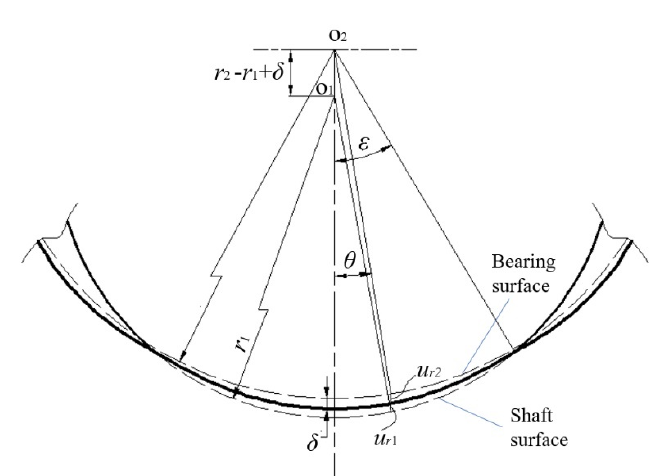
Figure 4. Cross-sectional schematic diagram of the geometric boundary of the aligned bearing.